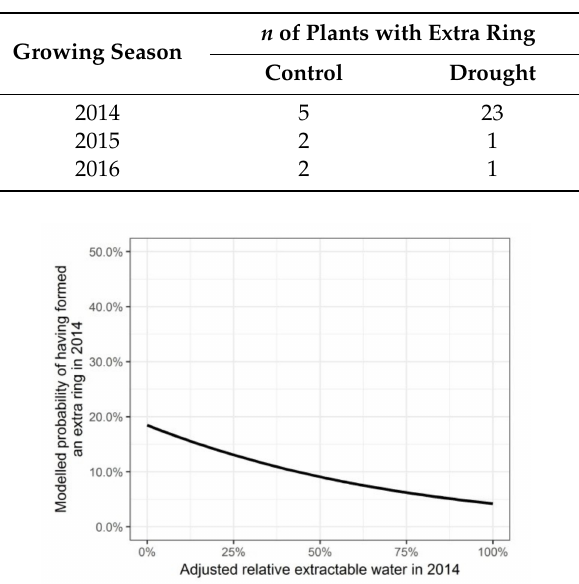
Table 4. Number of seedlings showing an intra-annual density fluctuation in the secondary xylem, depending on the water limiting treatment experienced by the seedlings in 2014.